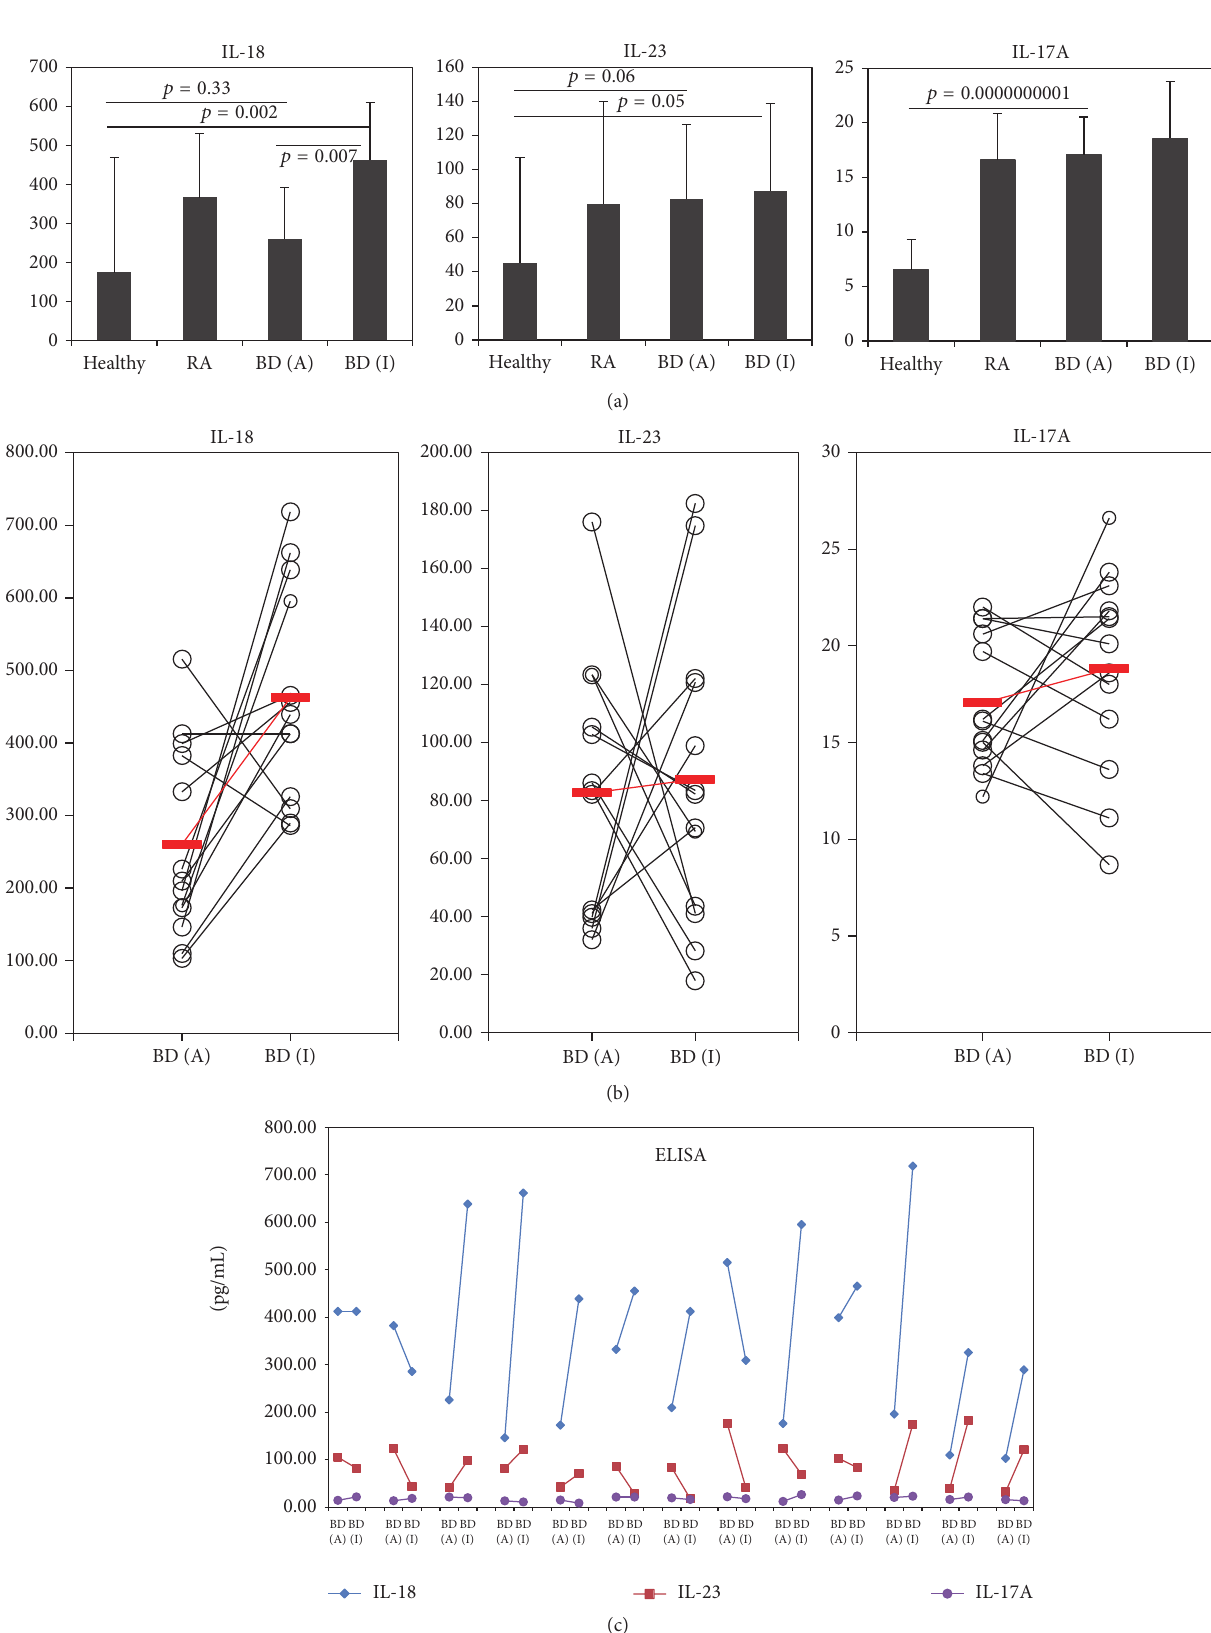
Figure 3: (a) Cytokine, IL-18, IL-23, and IL-17A expressions by enzyme-linked immunosorbent assay (ELISA) analysis in plasma of patients withactiveBD(BDA),inactiveBD(BDI),rheumatoidarthritis(RA),andhealthycontrol(HC).(b)Thechangeofcytokineexpressionbetween with BDA and BDI in individual